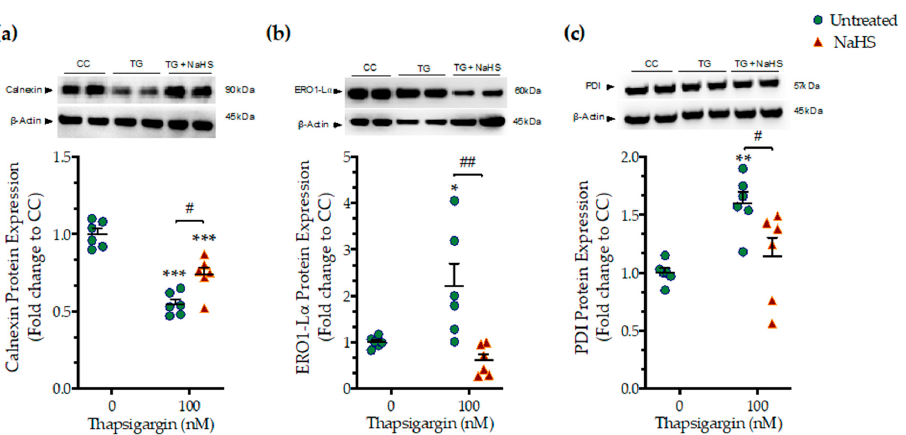
Figure 4. NaHS co-treatment partially counteracts the dysregulation of the expression of local chaperones for the ER folding machinery. HepG2 cells were serum-starved for 8 h and treated with the vehicle or 100 nM of thapsigargin (TG), in the presence or absence of 100 µM NaHS for 16 h. Cells were harvested and the extracted proteins were processed for Western blotting analysis of the expression levels of calnexin ( a ), ER oxidoreductase 1 α (ERO1-L α ) ( b ), and protein disulfide isomerase (PDI) ( c ). Each graph line represents mean ± SEM from three independent experiments. Data are expressed as a fold change of the control (vehicle-treated) conditions (CC). * p ≤ 0.05, ** p ≤ 0.01; *** p ≤ 0.001 compared to CC; # p ≤ 0.05, ## p ≤ 0.01 compared to TG-treated cells.